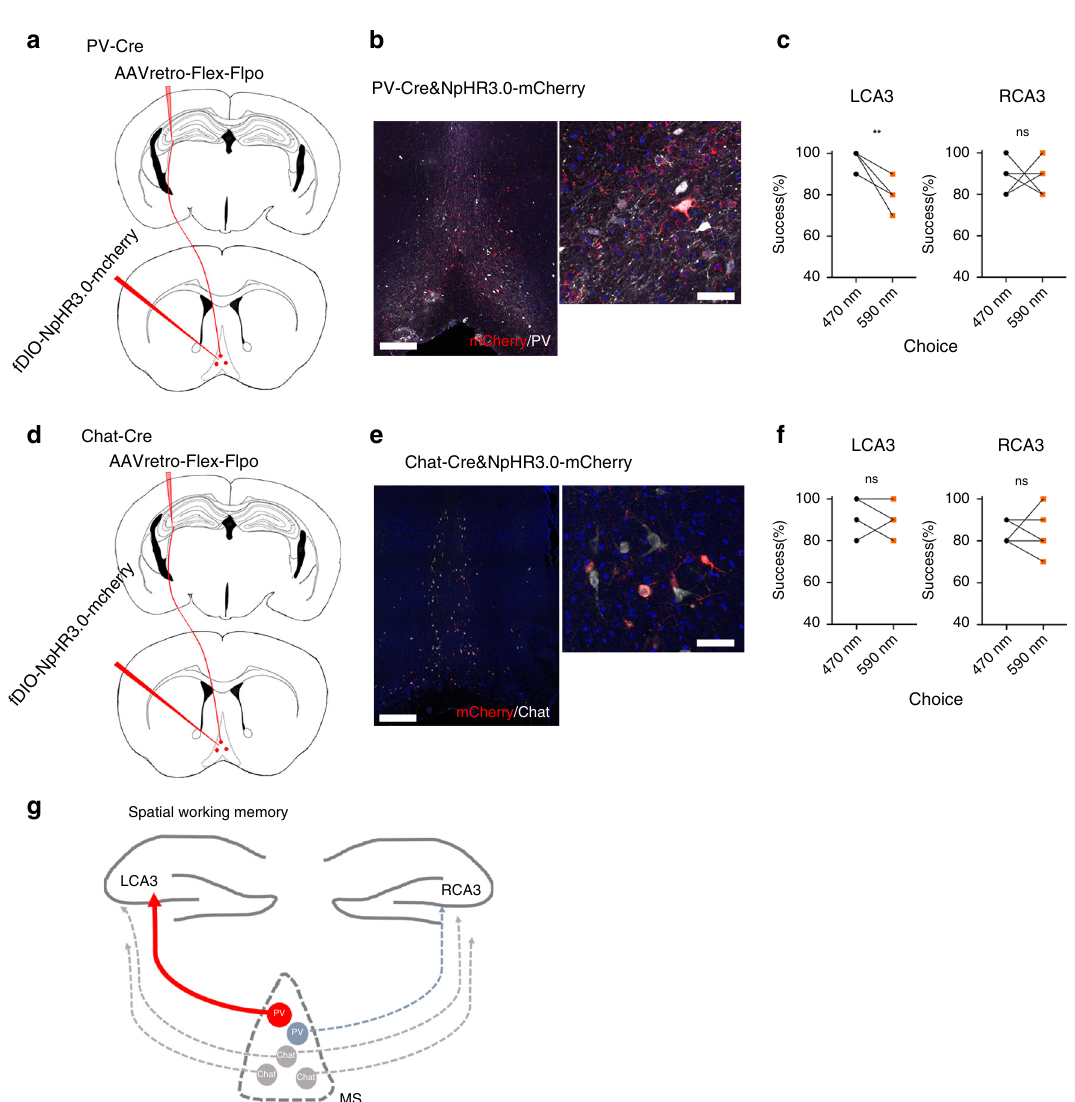
Fig. 6 Inhibition of MS PV -LCA3 projection impairs the retrieval of SWM. a Schematic of AAV-retro retrograde optogenetic system in PV-Cre mice. b Confocal images of coronal sections showing that mCherry + cells were co-labeled with PV (white) neurons. Scale bar: left is 200 μ m, right is 50 μ m. c Percentage of correct performance in mice receiving inhibition of MS PV -LCA3 ( n = 7) or MS PV -RCA3 ( n = 5) during the choice phase (two-tailed paired t-test, LCA3: ** P = 0.0019, RCA3: P > 0.9999). d Schematic of AAV-retro retrograde optogenetic system in Chat-Cre mice. e Confocal images of coronal sections showing that mCherry + cells were co-labeled with cholinergic (white) neurons. Scale bar: left is 200 μ m, right is 50 μ m. f Percentage of correct performance in mice receiving inhibition of MS Chat -LCA3 ( n = 6) or MS Chat -RCA3 ( n = 6) during the choice phase (two-tailed paired t-test, LCA3: P = 0.2031, RCA3: P = 0.7412). g A proposed model for MS PV -LCA3 projection that modulates the lateralization of SWM. Source data are provided as a Source Data fi